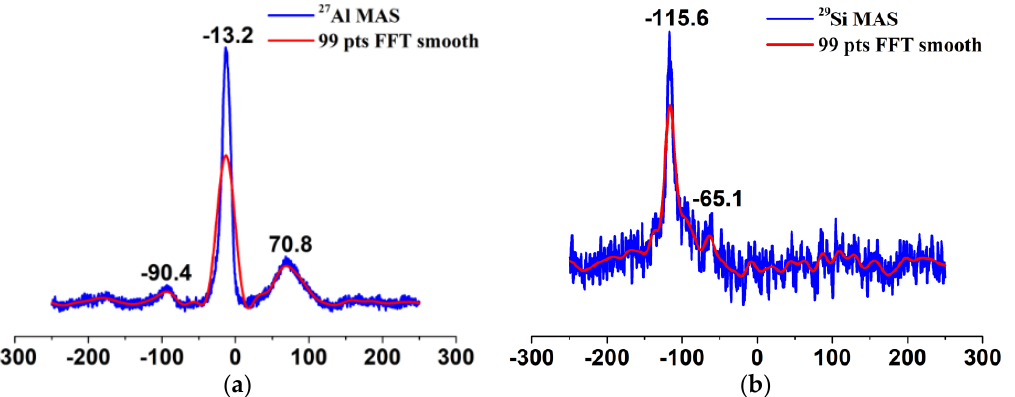
Figure 8. 27 Al MAS − NMR spectrum ( a ) and 29 Si MAS spectrum ( b ) of n − SiO 2 sample: the blue lines are the original data, and the red ones are the fitted data.